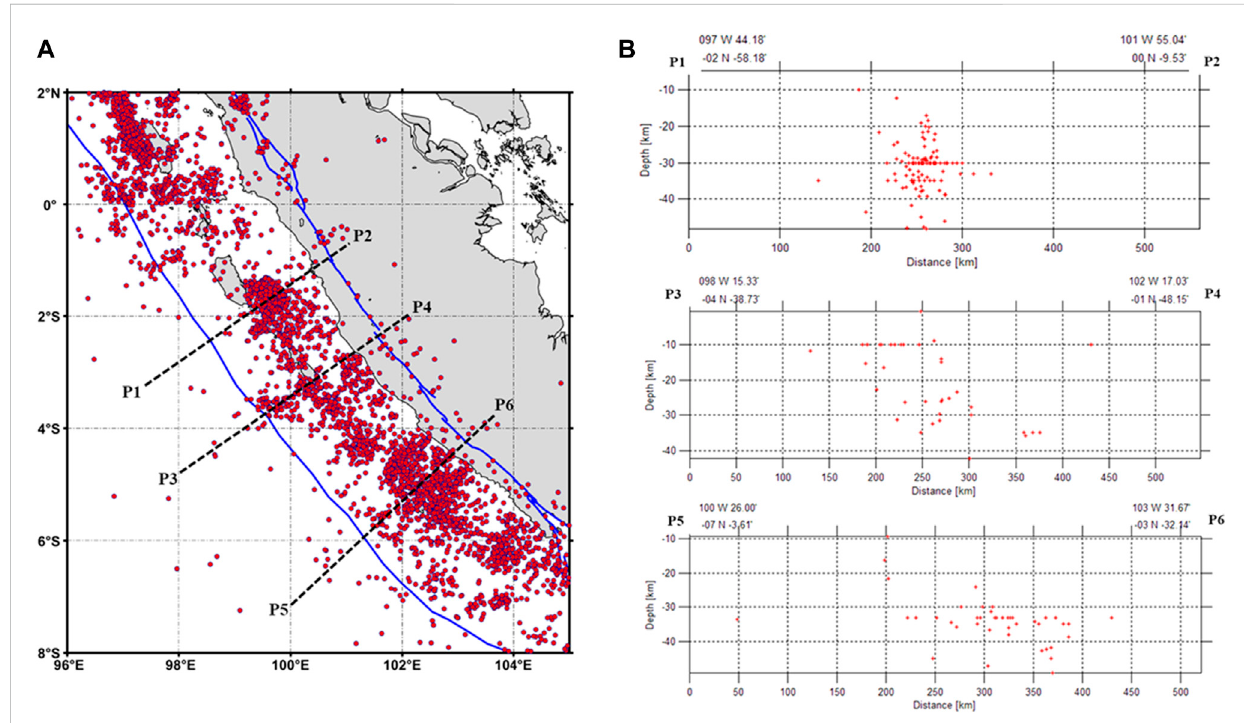
Distributionofshallowearthquakeswithdepthslessthan50 kmfrom1963to2016(The2017PuSGen,2017)andthecross-sectionsusingawidthof 10 km (B) . They are cross-sections P1 – P2, P3 – P4, and P5 – P6.